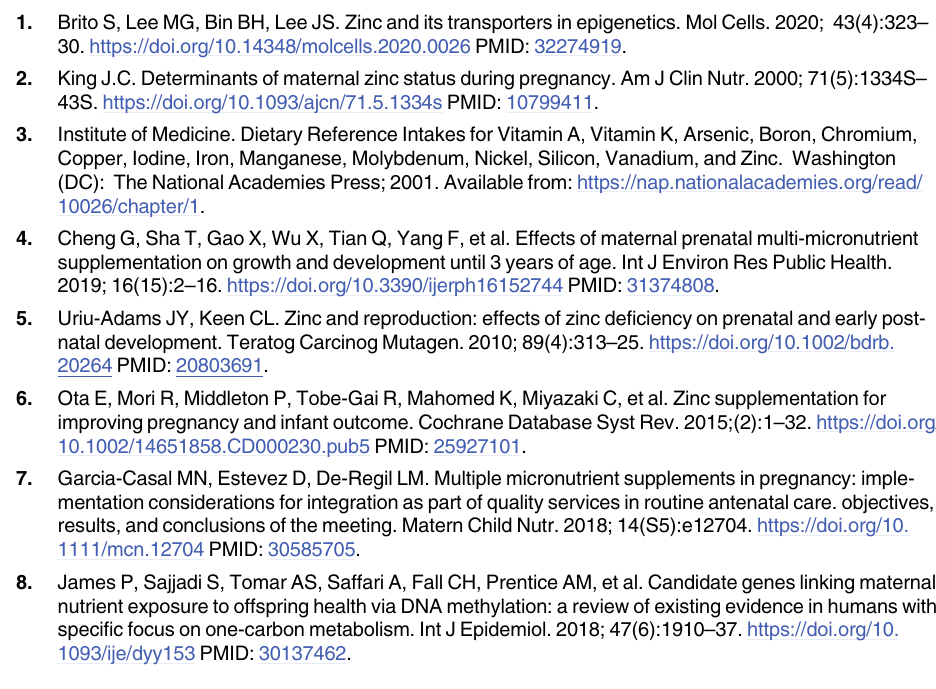
S2 Table. Linear associations between LINE-1 methylation and anthropometric and cardi- ometabolic outcomes in young adult offspring. S3 Table. Linear associations between Alu methylation and anthropometric and cardiome- tabolic outcomes in young adult